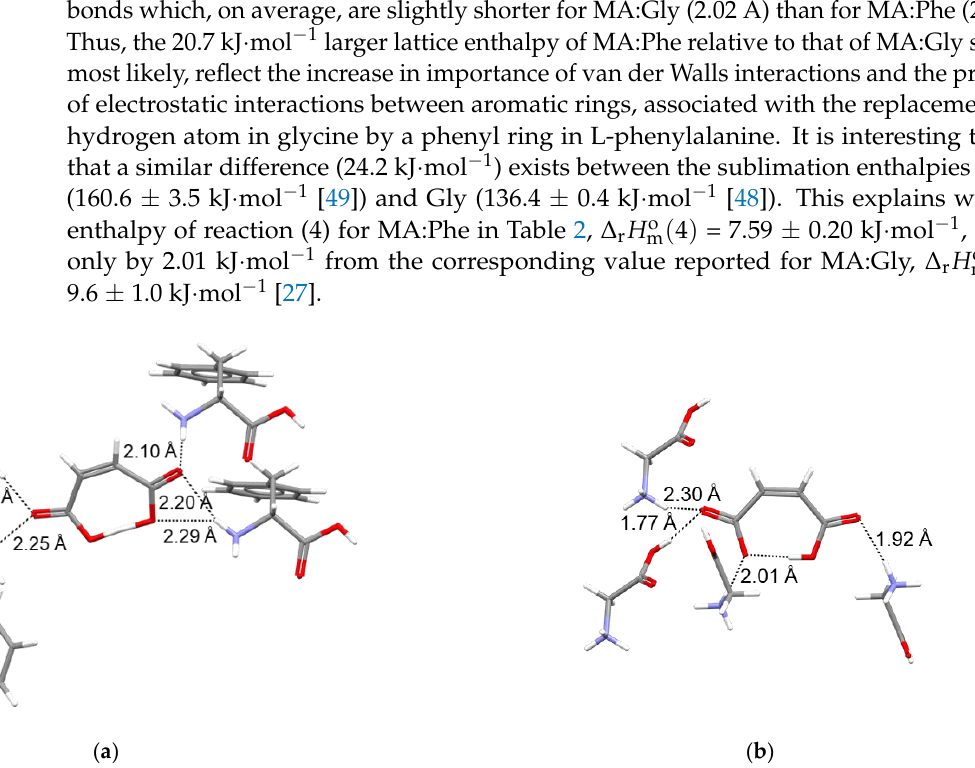
Figure 6. Hydrogen bond patterns around the maleate anion in ( a ) MA:Phe and ( b ) MA:Gly.